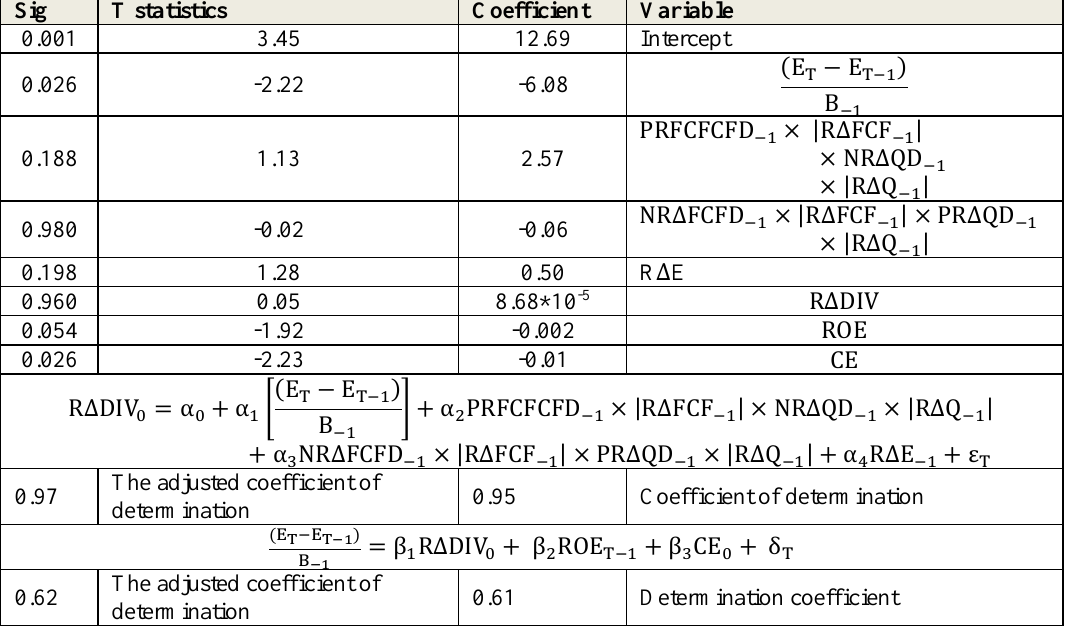
Variable Coefficient T statistics Sig